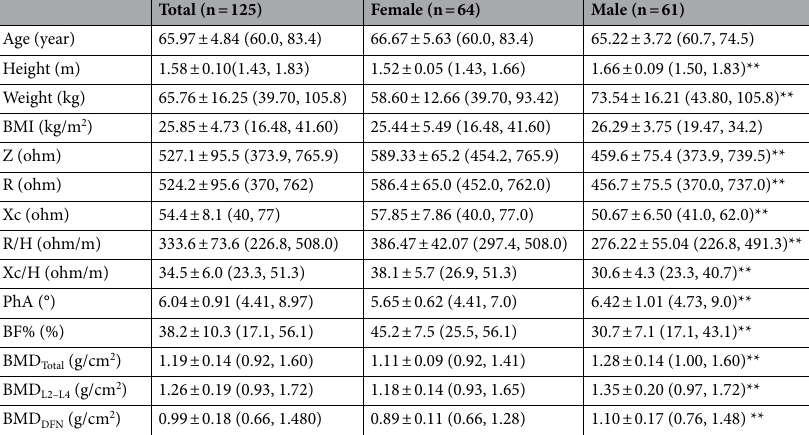
Table 1. Subject demographic. PhA phase angle, BF% percentage body fat. *p < 0.05. **p < 0.001. a Data are expressed as mean ± standard deviation (min, max). b Z, impedance, R, resistance, Xc, reactance, R/H, resistance standardized for height, Xc/H, reactance standardized for height. c Subscript total, L2–L4, and DFN denote whole body, AP spine L2–L4, and dual femur neck,